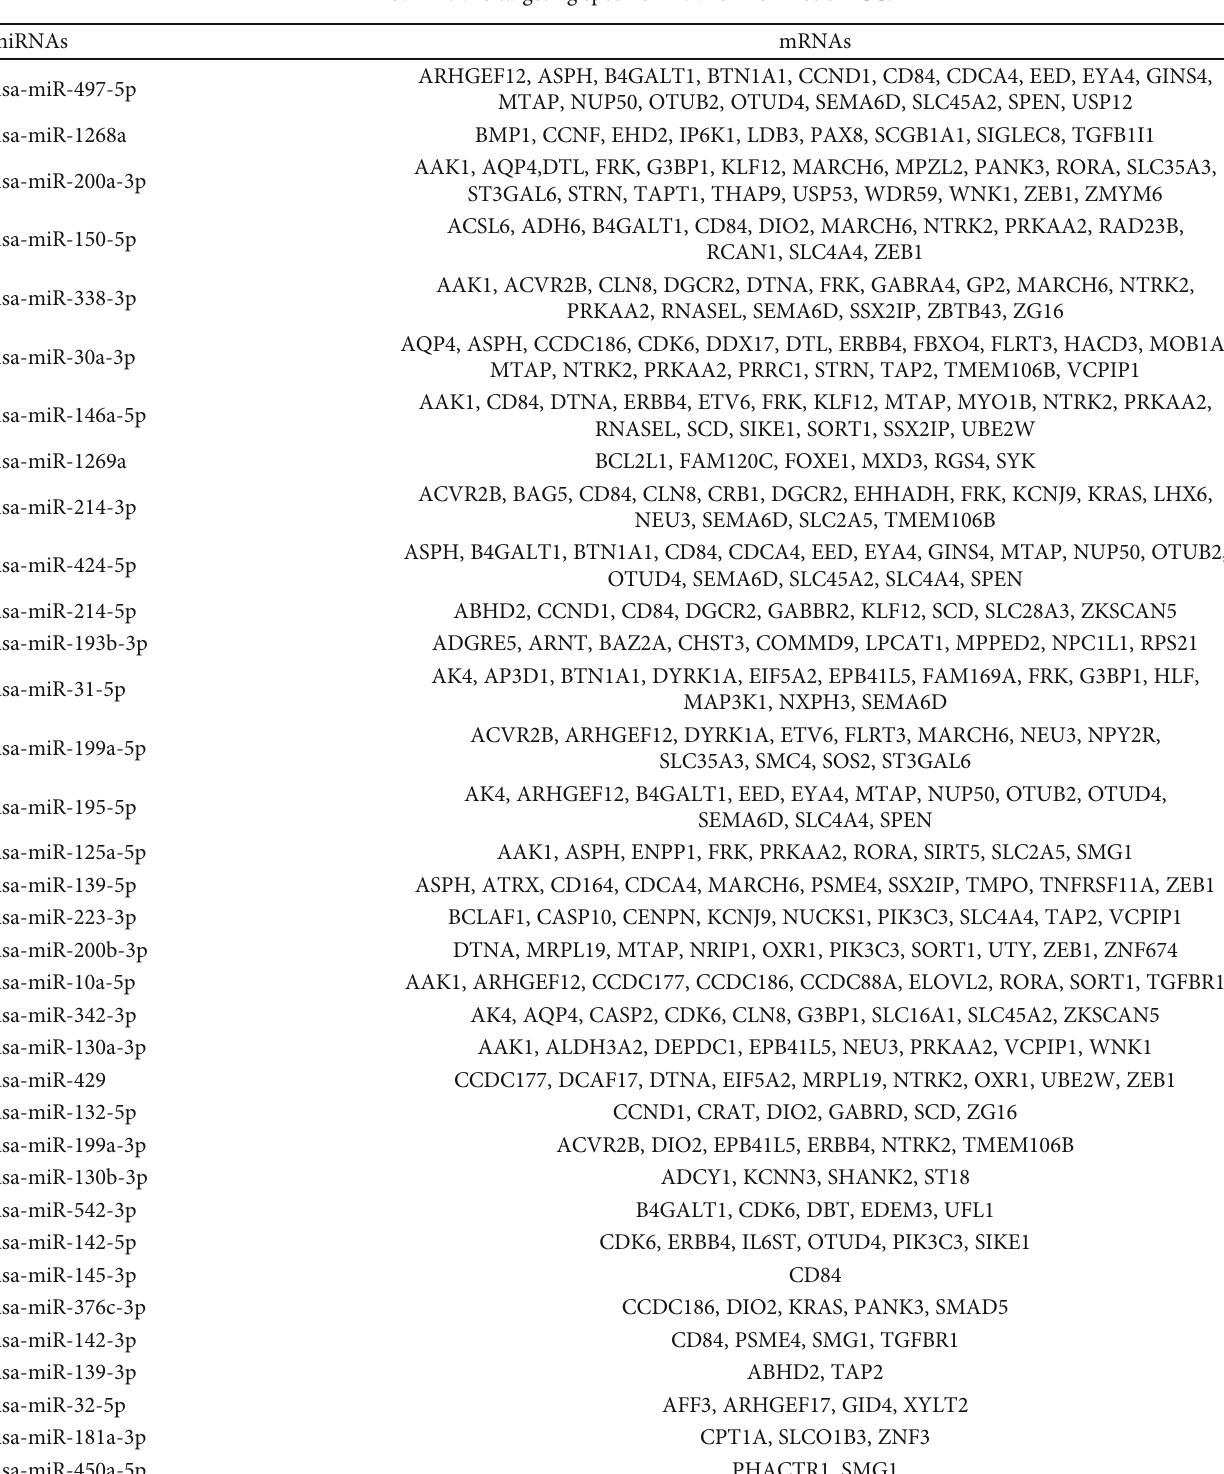
Table 3: miRNAs targeting speci fi c mRNAs in cirrhotic